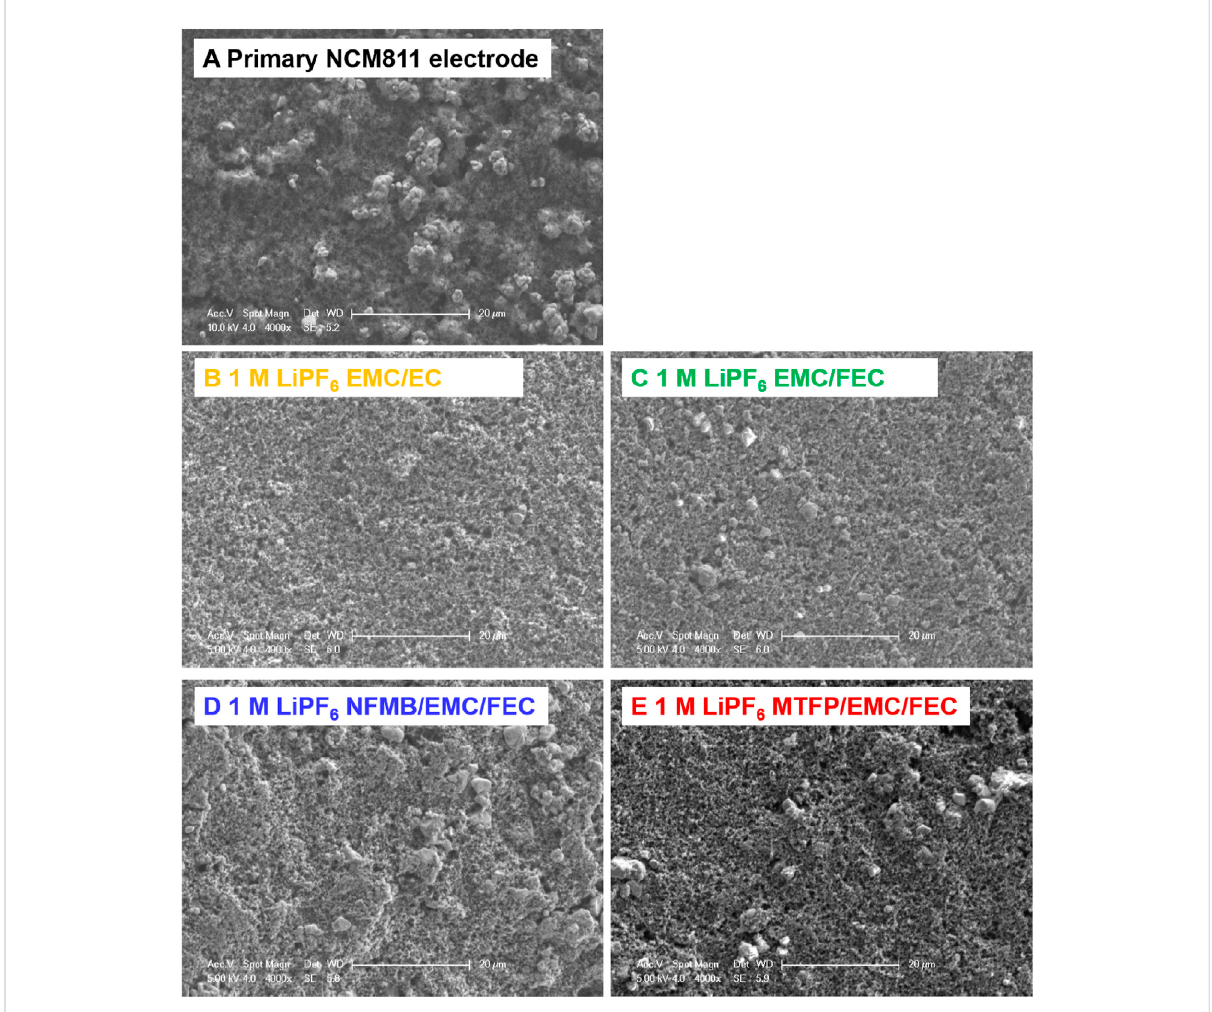
FIGURE 9 SEMimagesofelectrodesatdifferentstates: (A) primaryNCM811electrodeandcycledNCM811electrodeatacut-offvoltageof2.7 – 4.8 Vafter 50 cycles with different electrolyte solutions: (B) 1 M LiPF6 EMC/EC, (C) 1 M LiPF6 EMC/FEC, (D) 1 M LiPF6 NFMB/EMC/FEC, (E) 1 M LiPF6 MTFP/